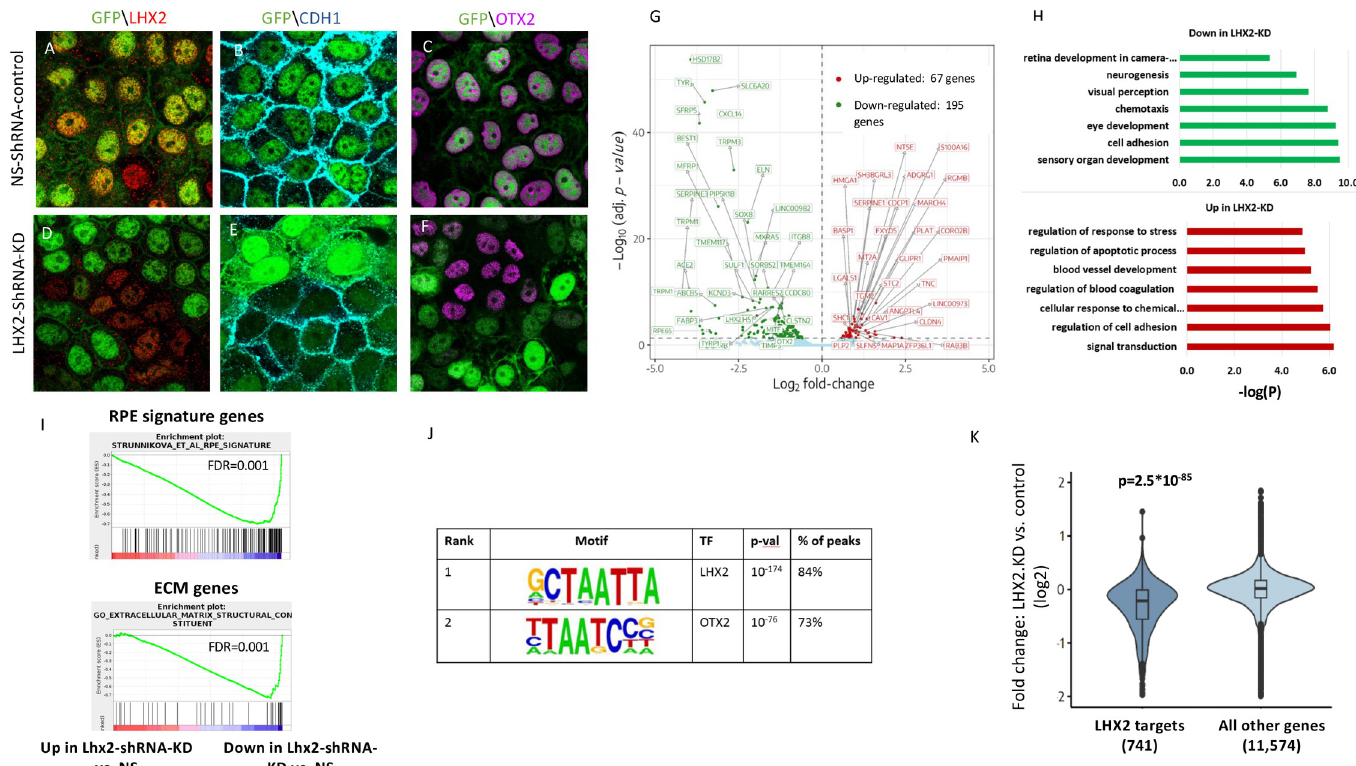
Fig 2. LHX2 is required for maintaining RPE fate in hES-RPE. (A–F) Lentiviral transduction of differentiated hES-RPE (d14) with control NS-shRNA (A–C) or LHX2-shRNA (D–F). GFP (green), expressed from the viral vector in the transduced cells. The NS-shRNA (A–C) or LHX2-shRNA (D–F) transduced cells were co-labeled with antibodies to GFP and LHX2 (A, D), CDH1 (B, E), OTX2 (C, F). Bar in A–F is 10 μ m. (G) Volcano plot for the differential expression analysis comparing LHX2-KD cells and NS-shRNA hES-RPE control differentiated (d14) hES-RPE cells (differential genes showed |FC| > 1.5 and FDR < 5%). (H) Enriched GO terms among the down- regulated and up-regulated genes in LHX2 KD differentiated (d14) hES-RPE cells (compared to control differentiated hES-RPE cells transfected by nonspecific shRNAs). (I) GSEA analysis shows that the genes down-regulated upon LHX2 KD in differentiated hES-RPE cells are significantly enriched for RPE signature genes and for ECM genes. (J) De novo motif analysis applied to the 1,278 peaks detected by LHX2 ChIP-seq identified highly significant enrichment for the binding motif of LHX2 and OTX2. (K) The set of putative LHX2 direct target genes as defined by ChIP-seq shows significant down-regulation of expression in hES-RPE cells knocked-down for LHX2. ECM, extracellular matrix; FDR, false discovery rate; GSEA, gene-set enrichment analysis; NS, non-silencing; RPE, retinal pigmented epithelium; shRNA, short hairpin